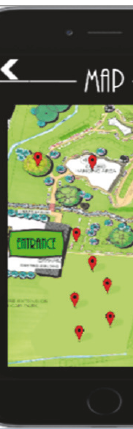
Figure 5: Information of the orchid based on genera.